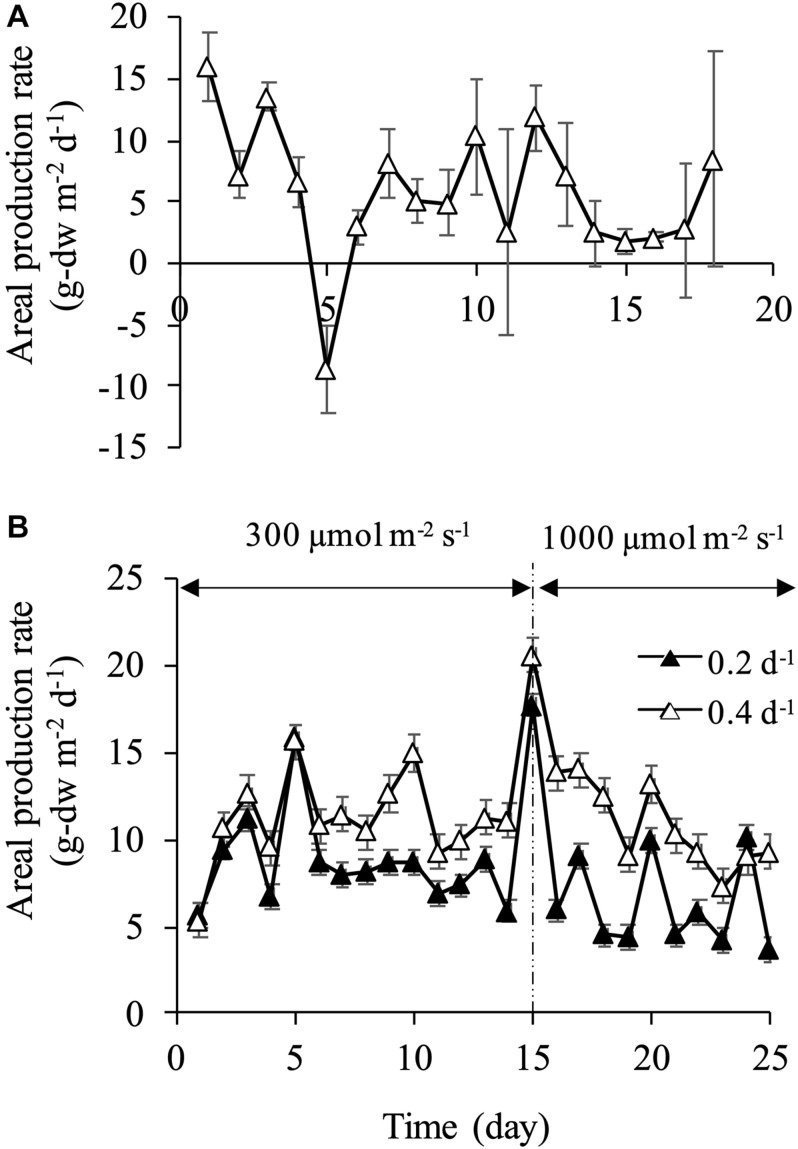
Areal and volumetric production rates at dilution rate of 0.1 d–1
(A) and dilution rates of 0.2 and 0.4 d–1 (B).